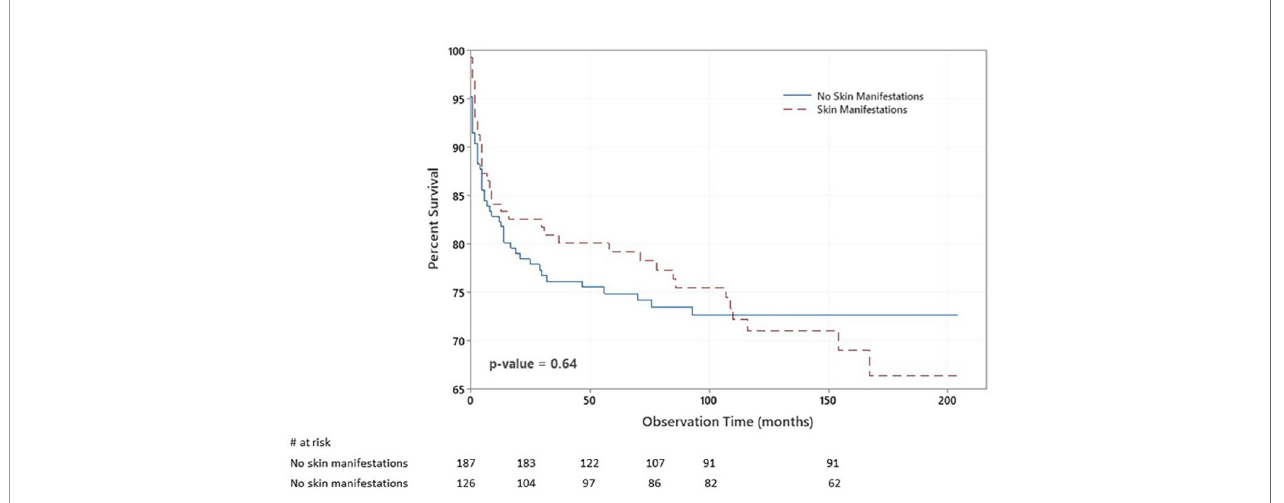
FIGURE 3 | Kaplan – Meier survival plot of the chance of survival among children with inborn errors of immunity (IEI) with respect to having skin manifestations. The probabilities that patients with no skin manifestations survived 2, 6, and 14 years after diagnosis were 77%, 74%, and 72%. At the same time, they were 82%, 74%, and 42% among patients with skin